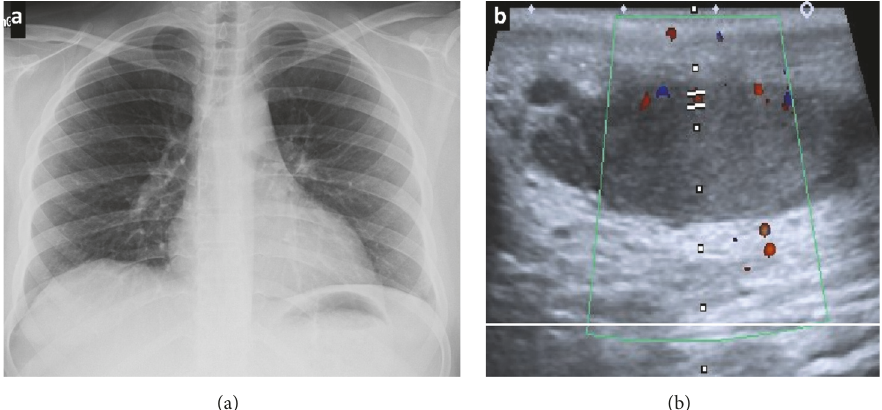
Figure 4: Chest X-ray. (a) There are no consolidations in the lung parenchyma or pleural effusion. US Testicular Doppler. (b) Testicle and left epididymis of normal size and